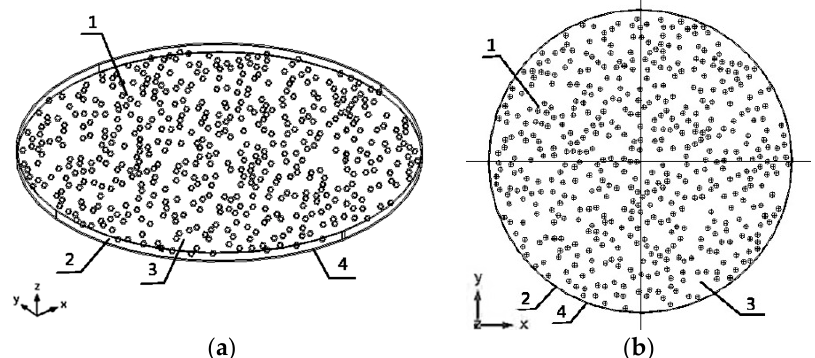
Figure 2. Schematic illustration of magnetic nanoparticle device: ( a ) the front view, ( b ) the vertical view.